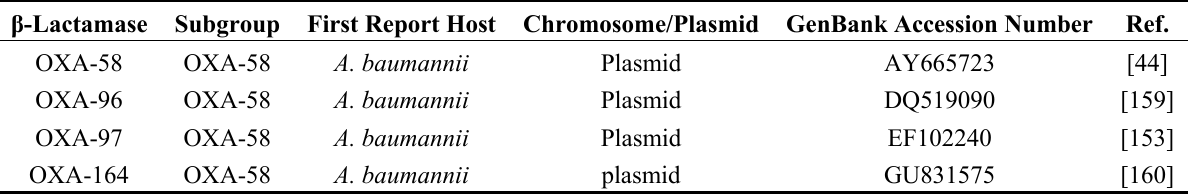
Table 13. OXA-58 like